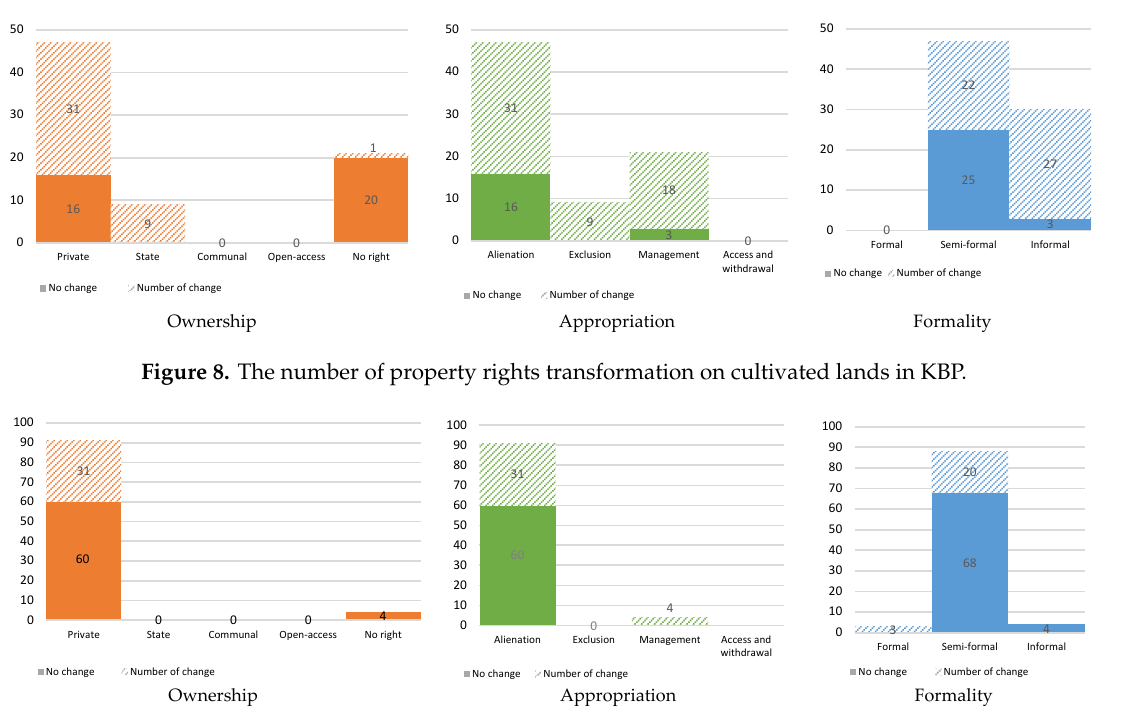
Figure 9. The number of property rights transformation on residential lands in KBP.